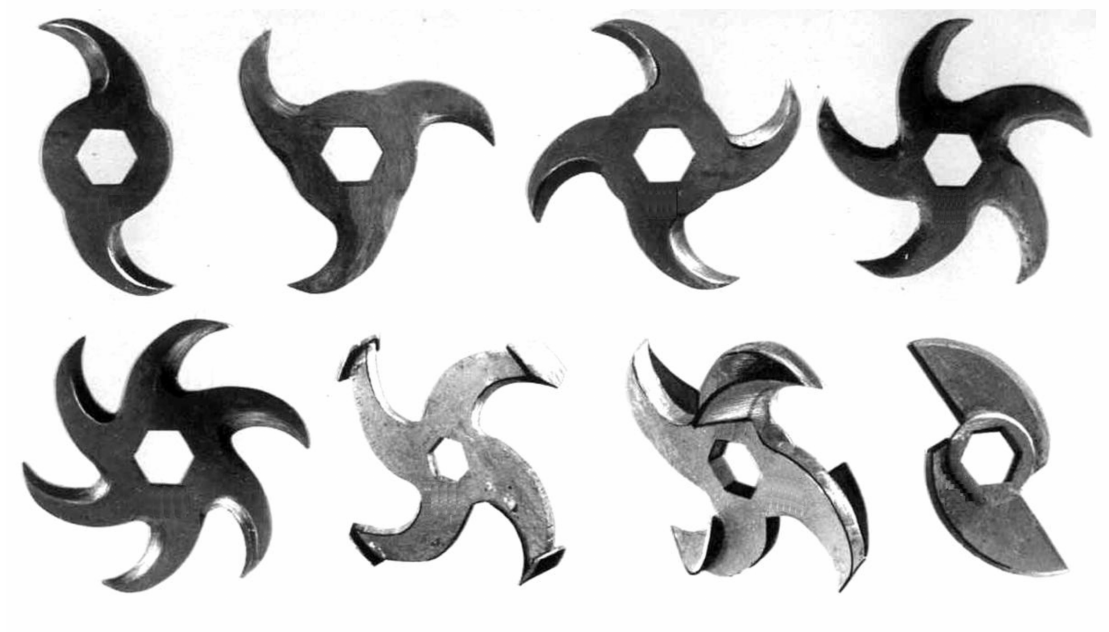
Figure 2. Disk cutters for intra-soil milling processing. From left to right, above: Two-teeth milling cutter; three-teeth milling cutter; four-teeth milling cutter; five-teeth milling cutter; below: Six-teeth milling cutter; four-teeth milling cutter with an expanded working body; four-teeth combined milling cutter with dumps; two-teeth screw milling